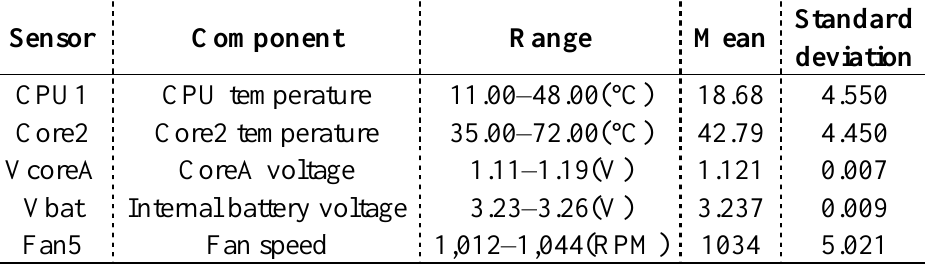
Table 2. Sensors used for evaluation and the range of sensor output